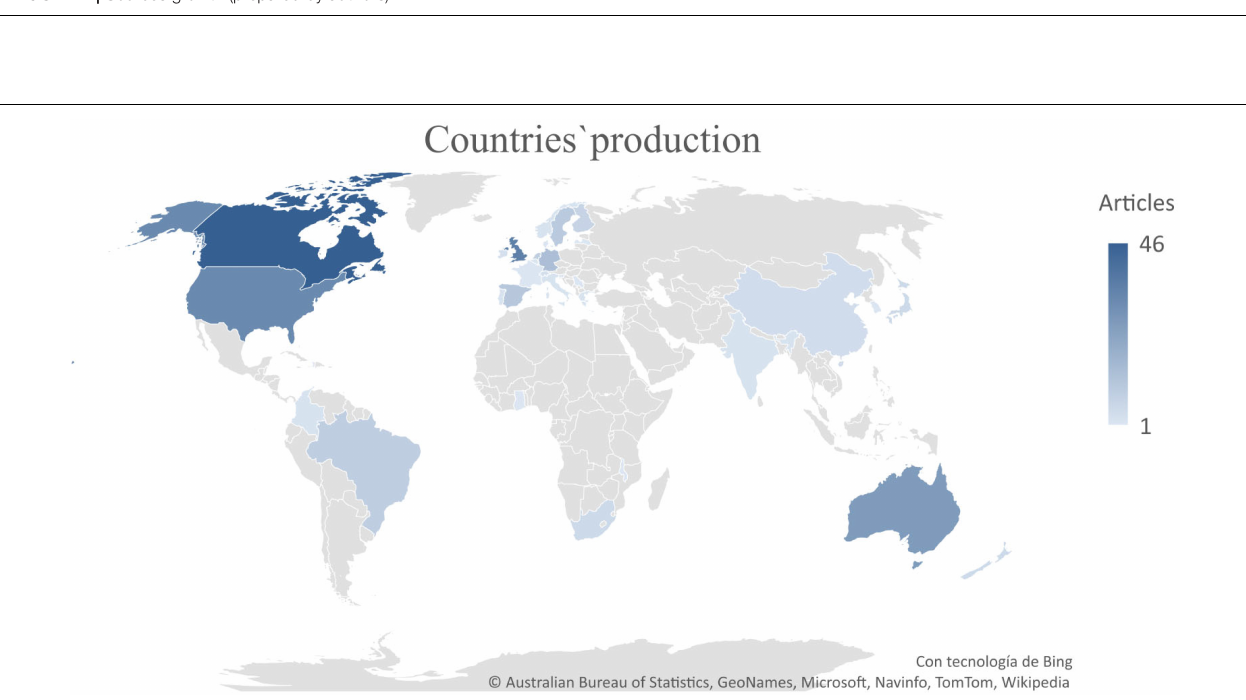
FIGURE 2 | Sources growth (prepared by authors).